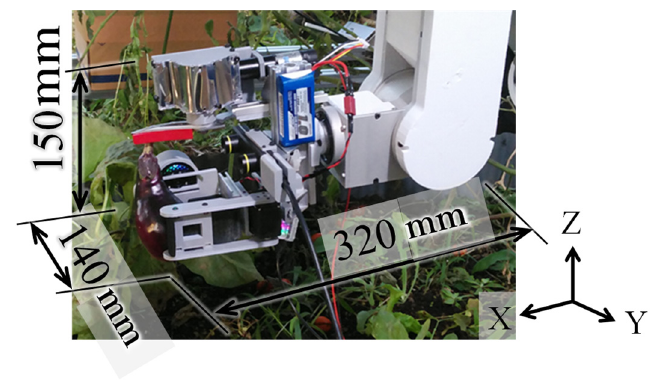
Figure 18. Harvesting an eggplant in a